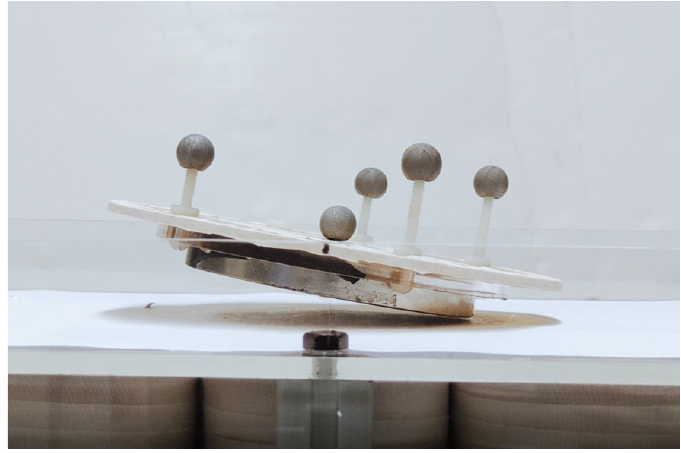
Figure 18. The disc magnet mover levitated at 26 mm and rotated with pitch angle θ of 10